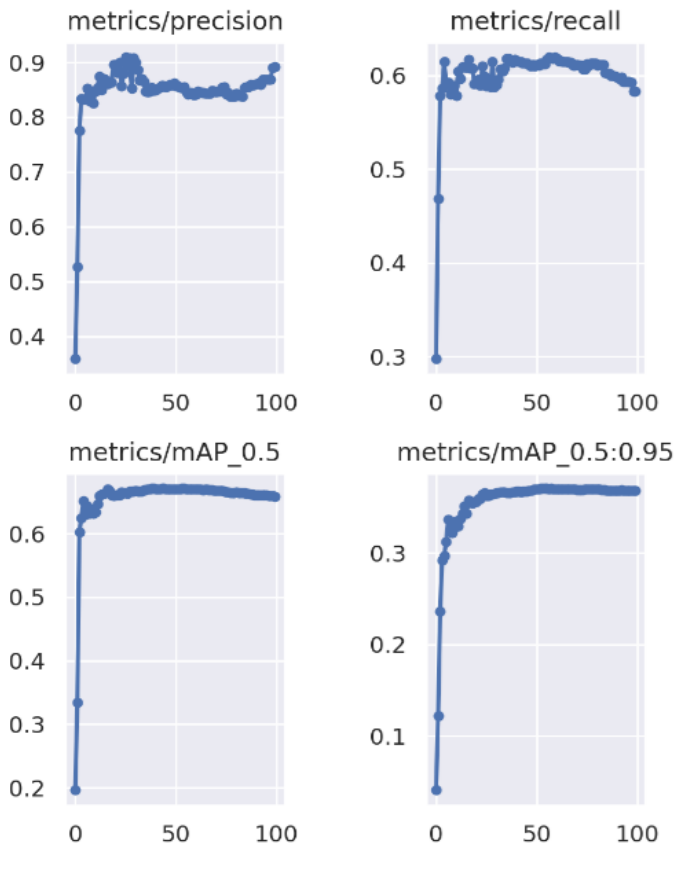
Figure 14. Training on the SEAGULL—progress of metrics during the 100 epochs.